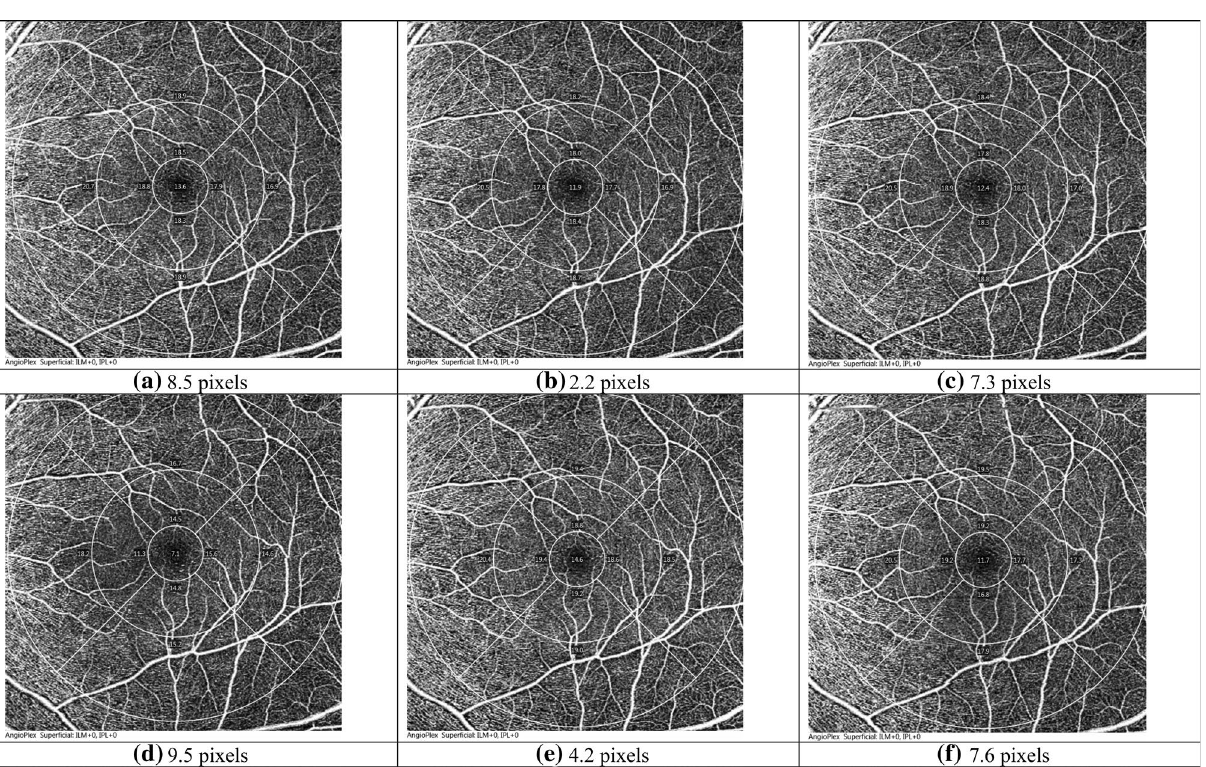
Figure 7. Three OCTA images from subject #032. ( a – c ) Correction with auto-focus (mean FD: 6.0 pixels; TRR: 3.3 pixels); ( d – f ) Correction with contact lens (mean FD: 7.1 pixels; TRR: 2.7